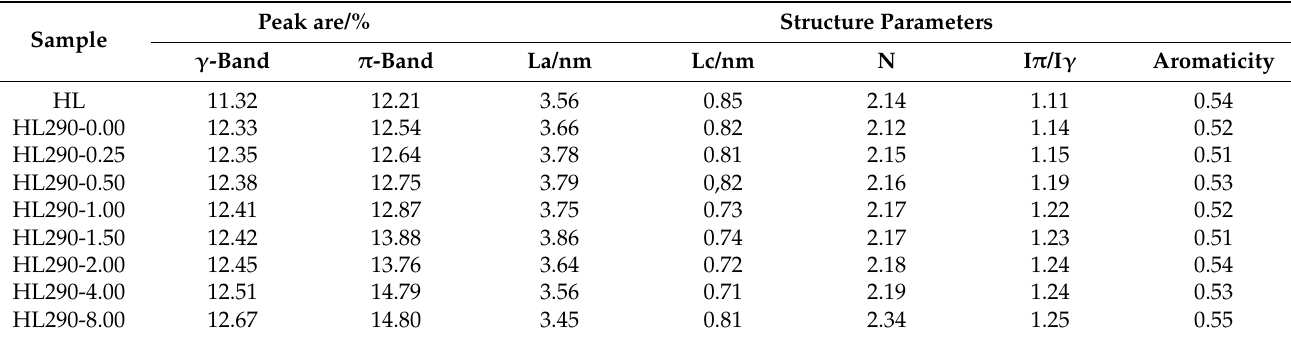
Table 2. Structural parameters of lignin and thermal materials for different insulation